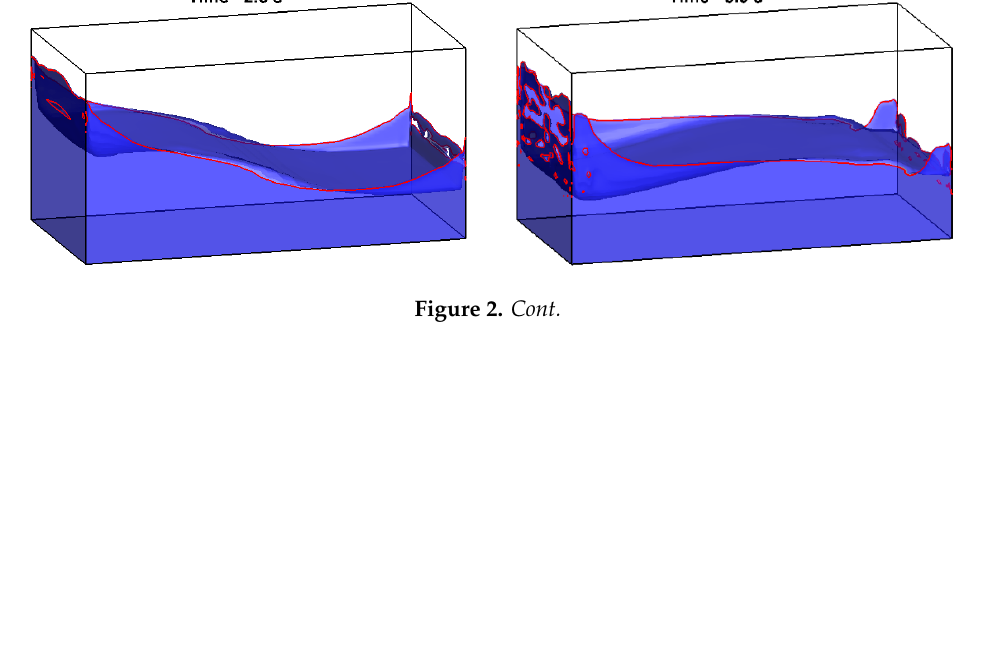
Figure 1. Comparisons of time histories of the dynamic pressures between the present numerical result (solid line) and experimental data (circle): ( a ) 3 cm away from the bottom, ( b ) 7 cm away from the bottom.